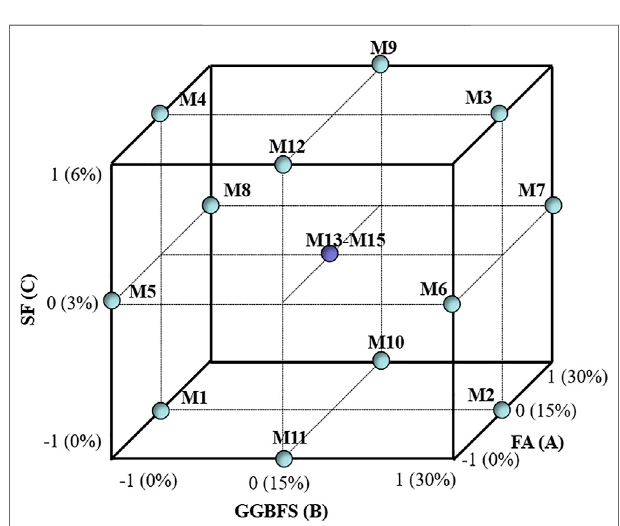
FIGURE 5 | The schematic of